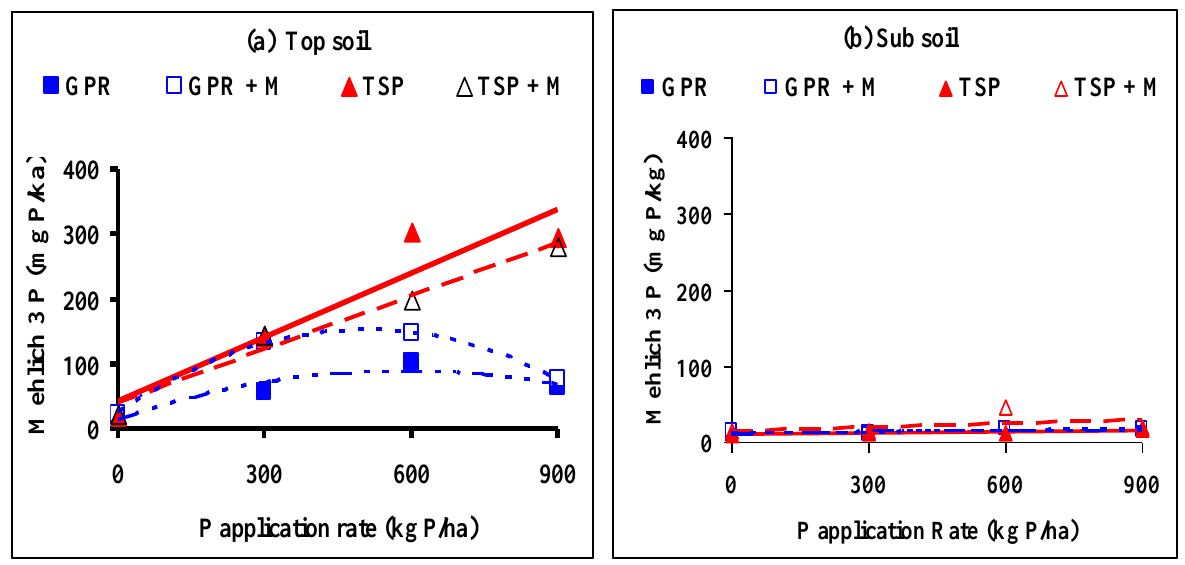
FIGURE 5. Relationship between Mehlich-3 extractable P and different rates of P applied in the (a) top- and (b)